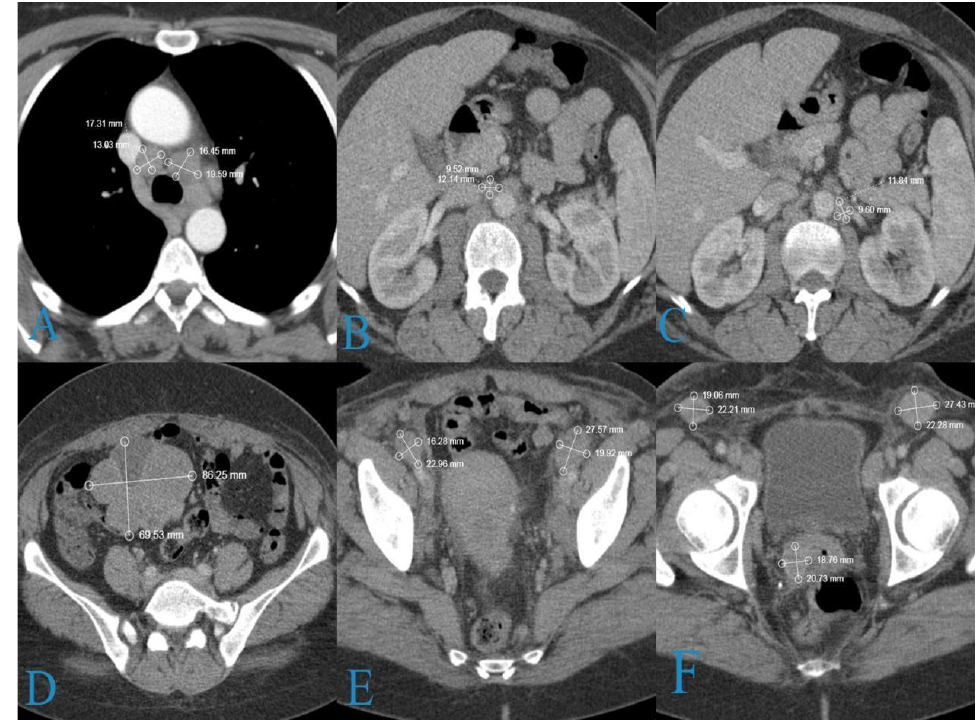
Figure 3. CT findings: ( A ) low paratracheal group (19/14 mm); ( B ) right paraaortic lymph nodes (11/9 mm); ( C ) left paraaortic lymph nodes (20/10 mm); ( D ) right ovarian tumor formation (87/69 mm); ( E ) common iliac lymph nodes (23/17 mm on the right and 28/18 mm on the left); ( F ) soft tissue lesion in the cervix (35/25) mm and inguinal lymph nodes (22/18 mm on the right and 27/23 mm on the left).